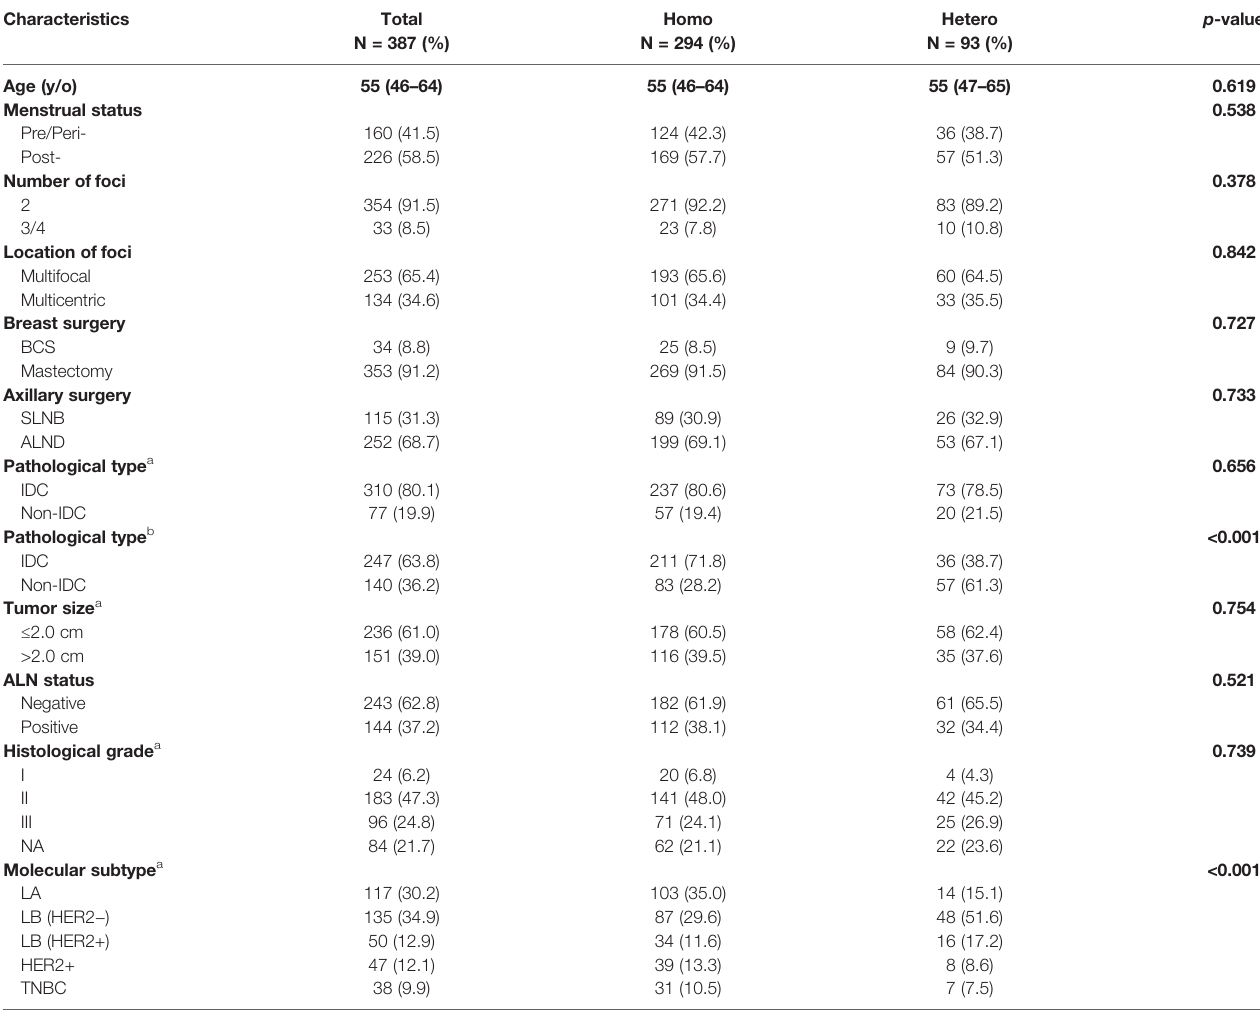
TABLE 1 | Baseline clinical and pathological characteristics.